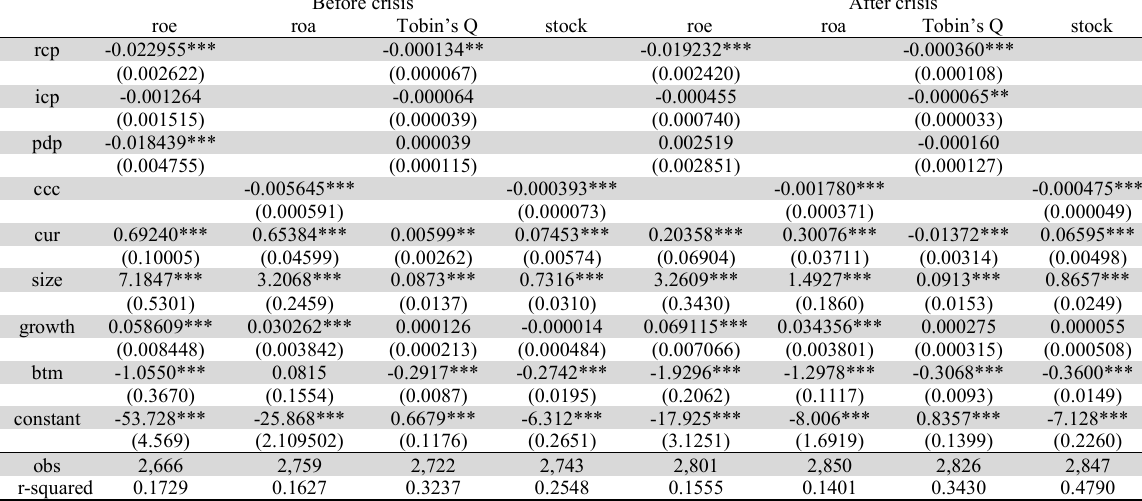
Impact of working capital management before and after the subprime crisis Before crisis After crisis roe roa Tobin’s Q stock roe